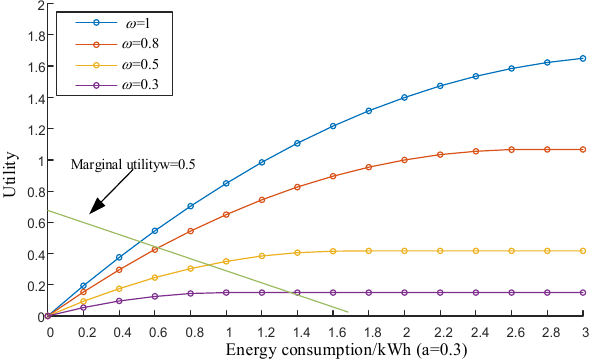
Figure 5 . Utility function of consumers energy usage. Figure 5. Utility function of consumers energy